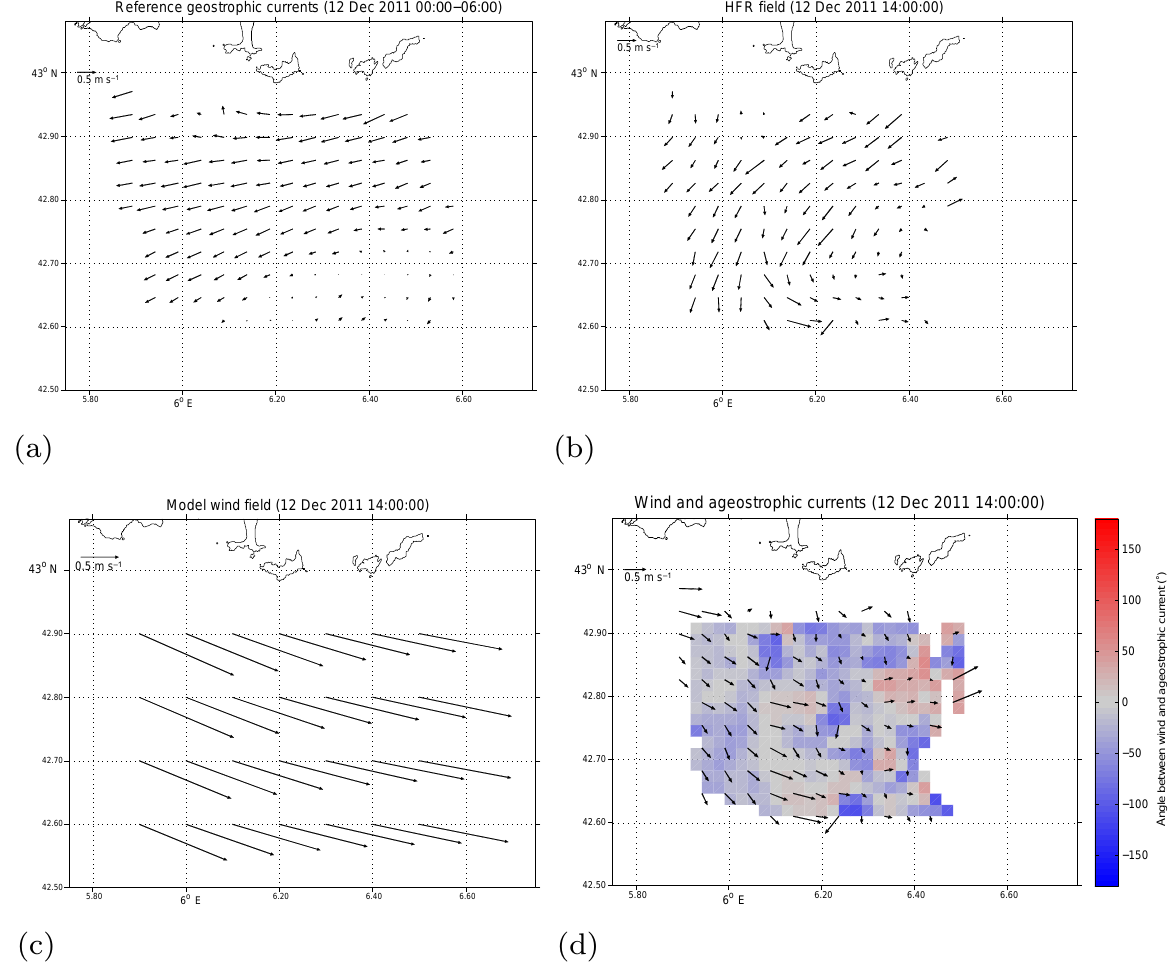
Figure 11. Example maps of (a) 6h time-averaged geostrophic flow u Sg derived from HFR prior to the wind onset, (b) instaneous HFR surface currents u S during the wind event, (c) ALADIN wind field, and (d) ageostrophic surface currents u SaW superimposed on the color- coded map quantifying the angle α between the ageostrophic component and ALADIN wind. Negative values indicate current to the right of the